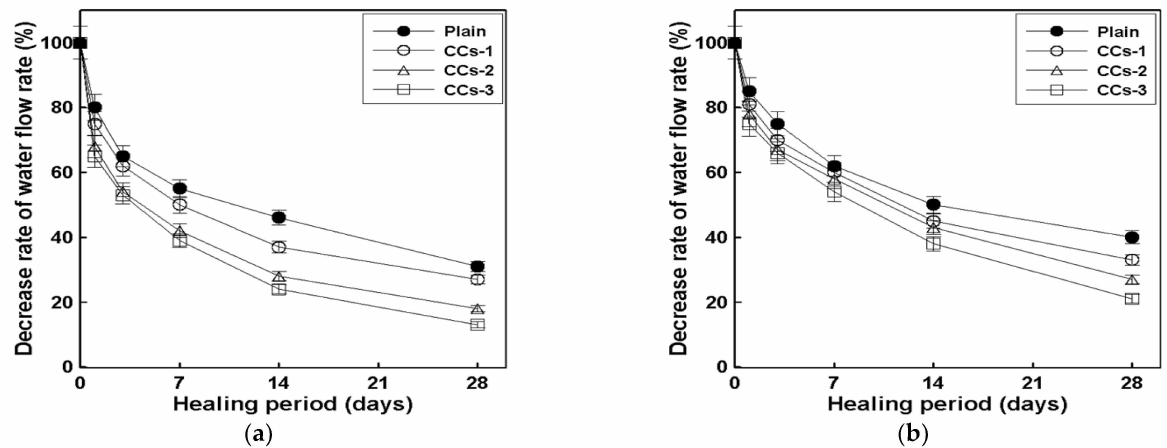
Figure 9. Correlation between the healing period and the decrease in the water flow rate: ( a ) crack induction at 7 days; ( b ) crack induction at 28